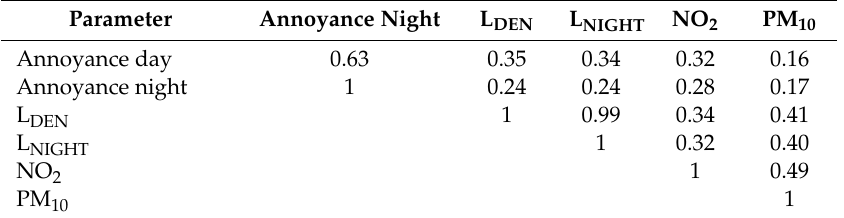
Table 3. Spearman correlations of the residential characteristics in the analysis sample ( N = 288).